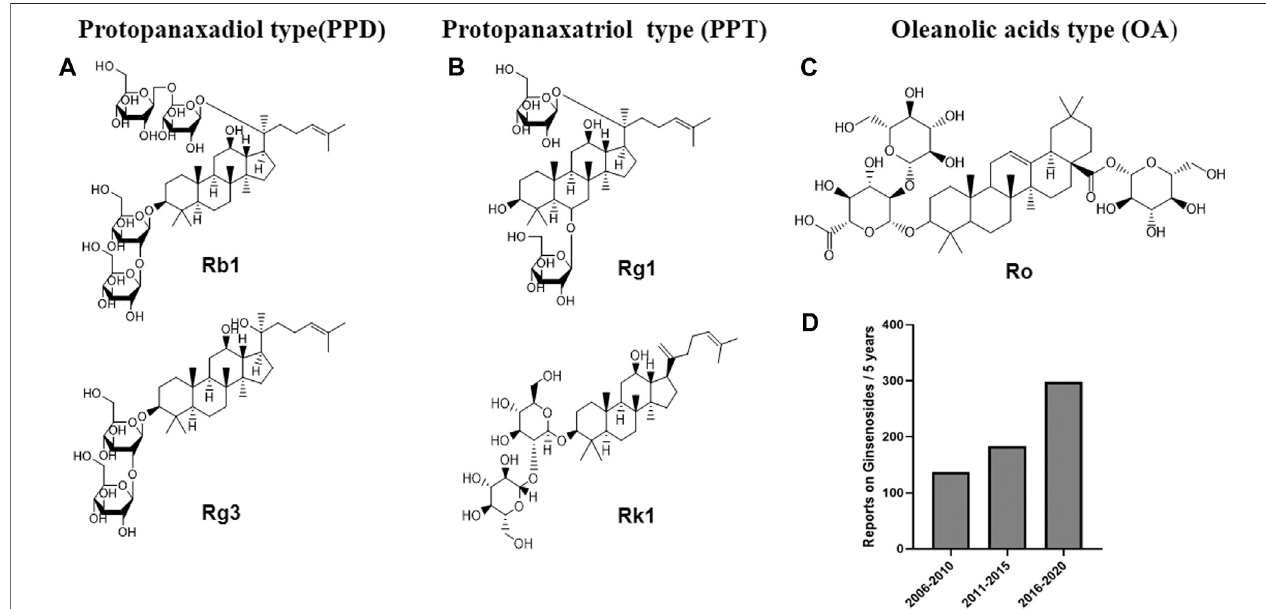
FIGURE 1 | Chemical structures of representative primary ginsenosides from ginseng for improving obesity and its complications targeting at gut microbiota. (A) . Protopanaxadiol type(PPD), (B) .Protopanaxatriol type (PPT), (C) . Oleanolic acids type (OA), (D) . Literature deposited in the PubMed database from 2006to 2020using ginsenosides, obesity and complications as subject